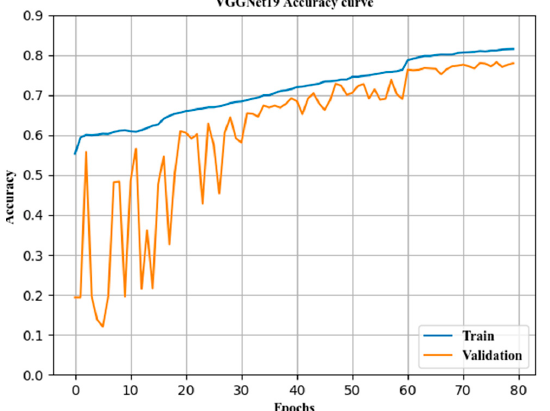
Sensors 2021 , 21 , 122 Figure 8. The classification accuracy curve of the VGGNet19 model. Figure 8. The classification accuracy curve of the VGGNet19 model.